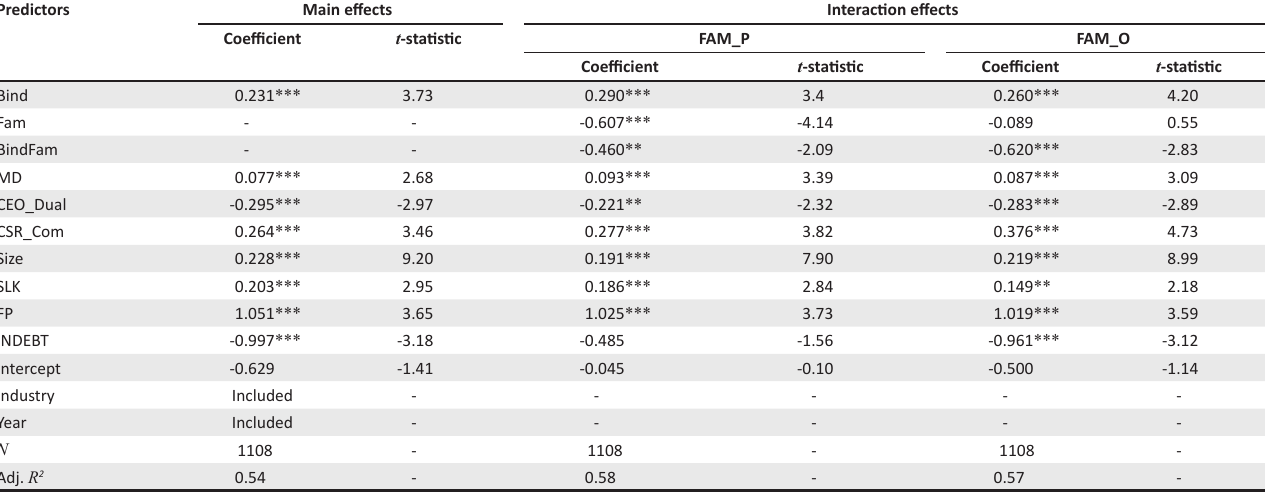
TABLE 4: Multiple regression with propensity score matching. Predictors